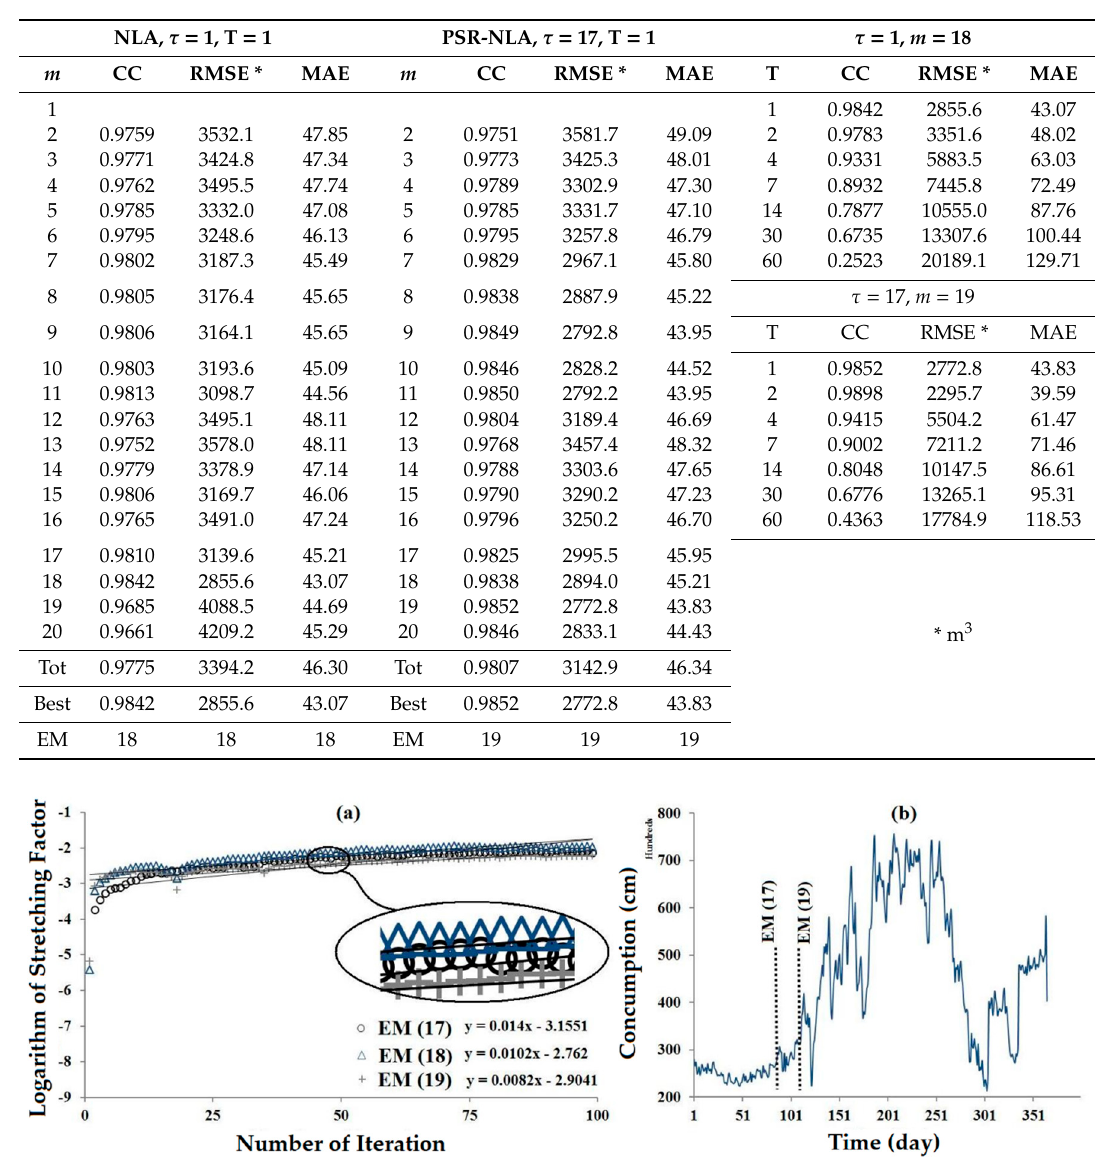
Figure 7. Estimation of largest Lyapunov exponent for daily consumption ( a ) for embedding dimension of 17, 18 and 19; ( b ) Observed values of water consumption in the test period.